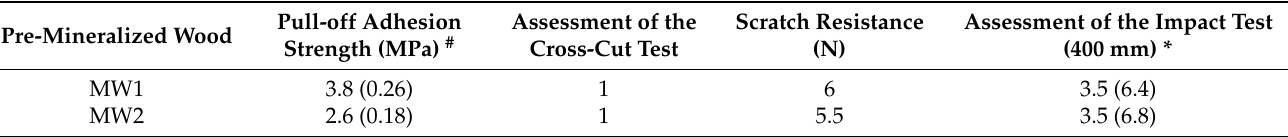
Table 4. Coating performances of CF7 on pre-mineralized wood samples (MW1 and MW2 wood mineralized with potassium water glass, and then boric acid or sodium bicarbonate, respectively). Pre-Mineralized Wood